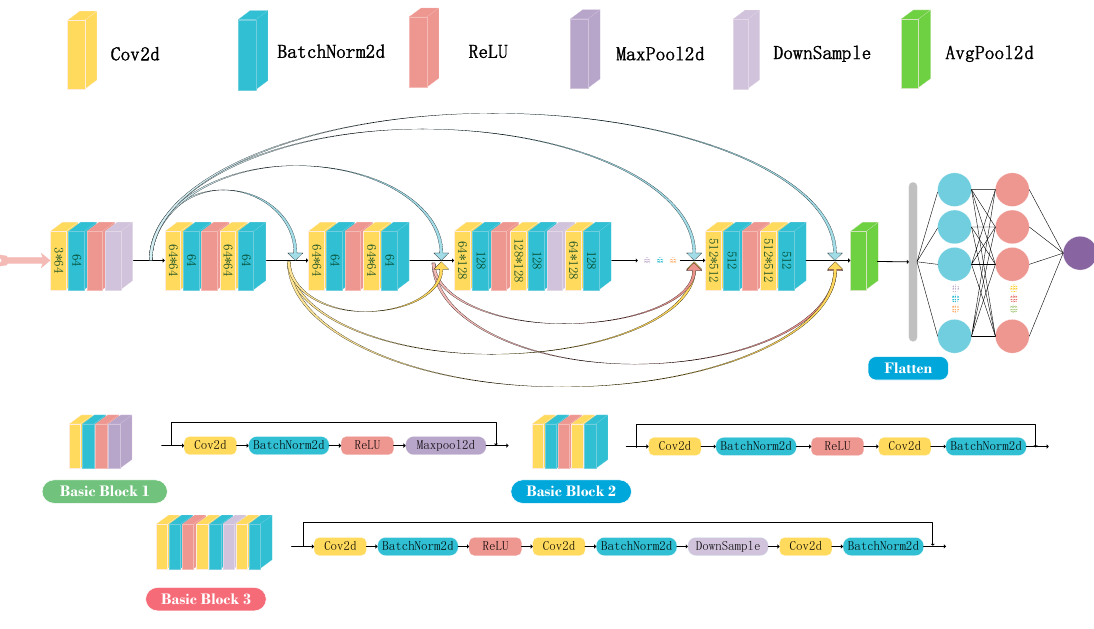
Figure 7. Overall architecture of proposed Resnet.